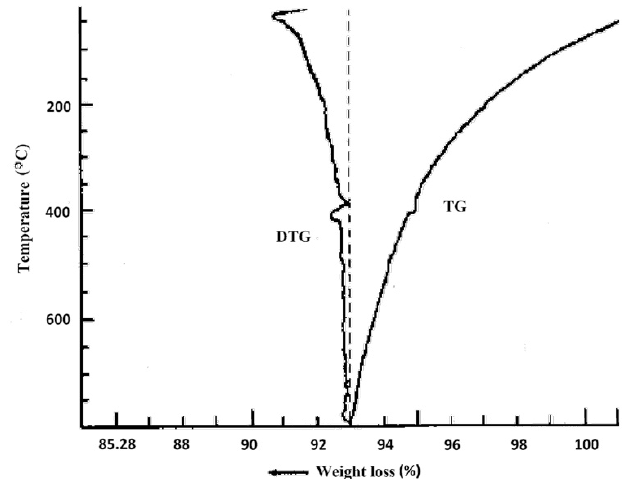
Fig. 2. DTG/TG spectrum of the zeolite type of clinoptilolite Fig. 2.